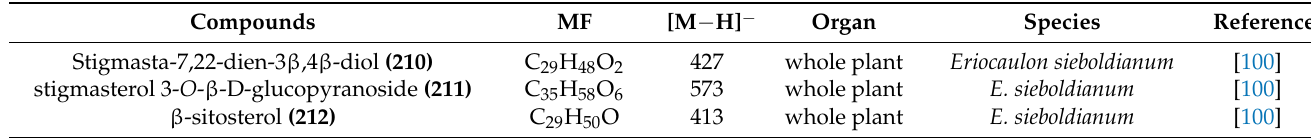
Table 6. Steroids isolated from Eriocaulaceae species.